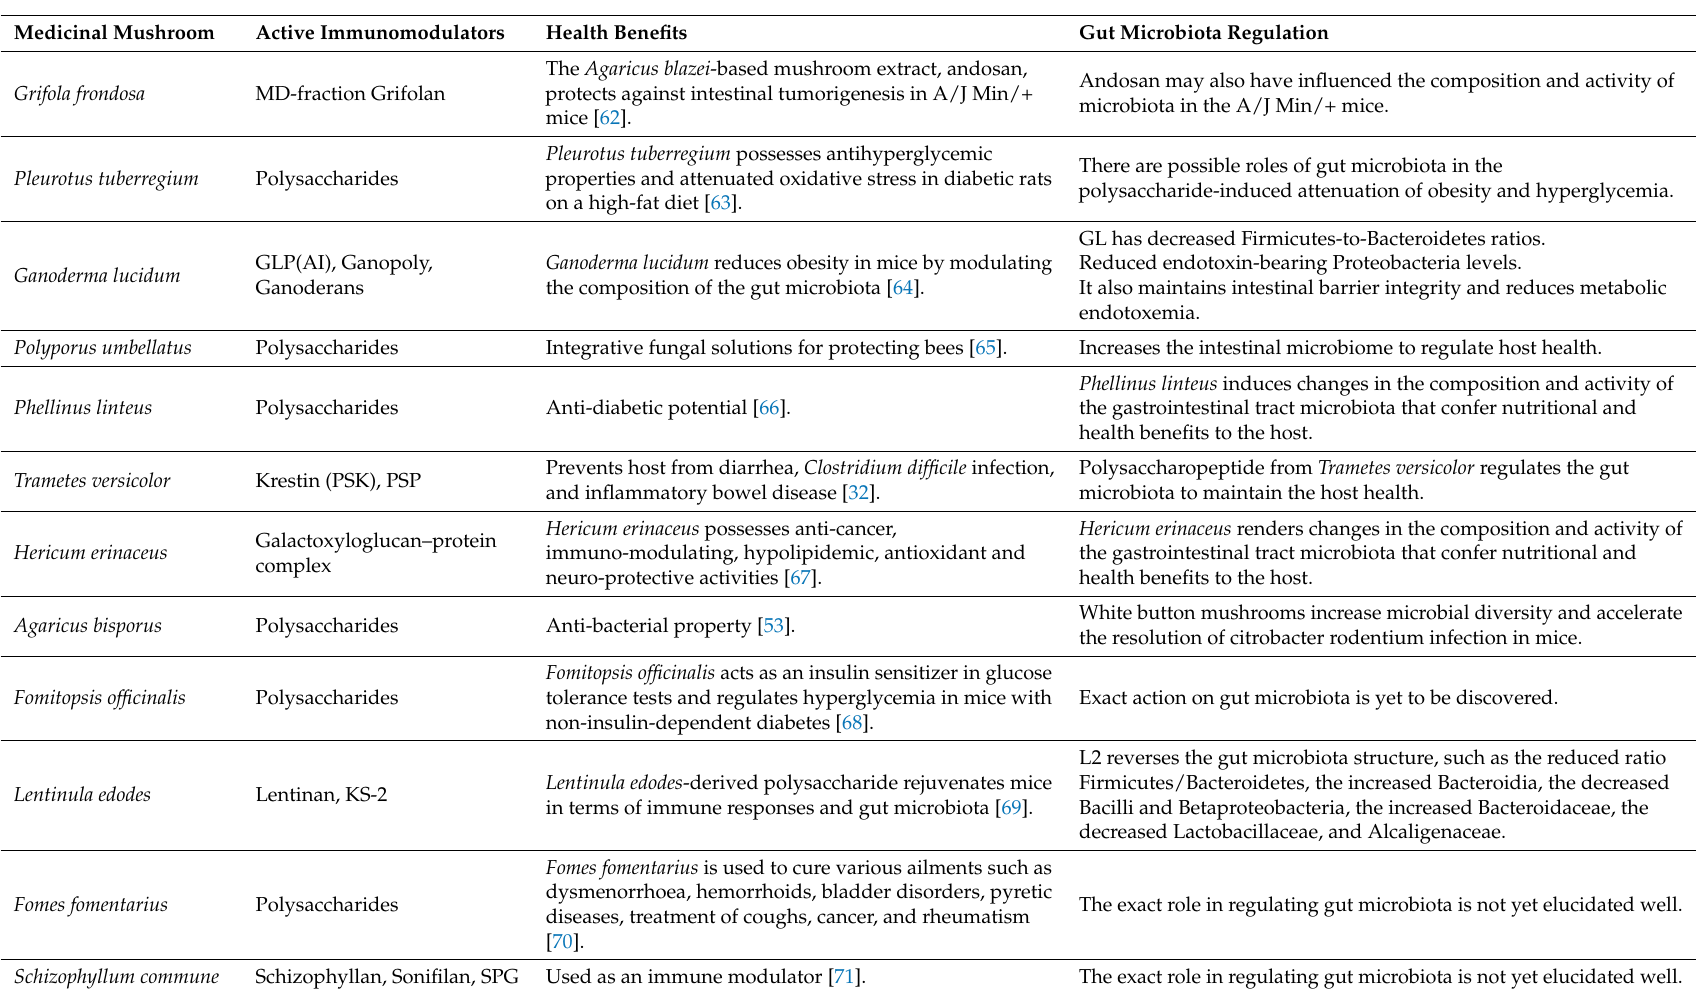
Table 1. List of important medicinal mushrooms and their pharmacological